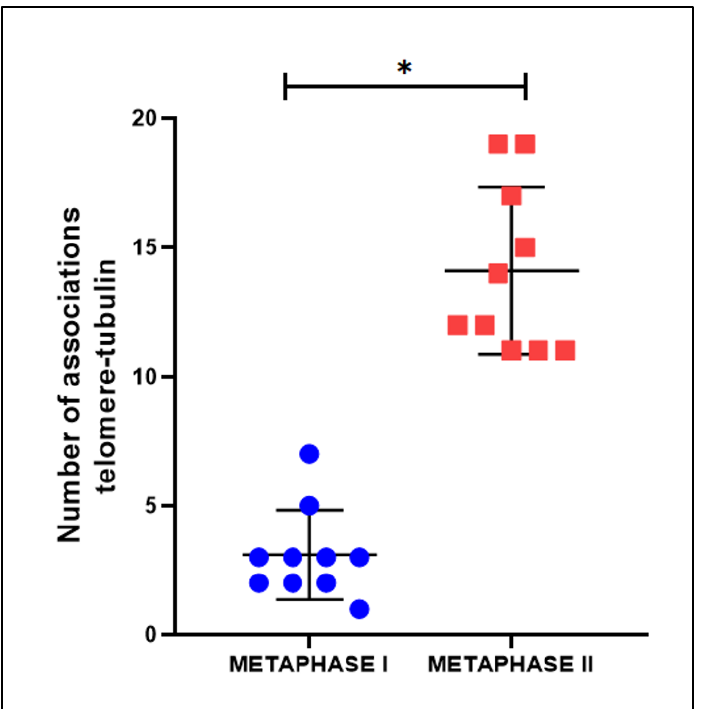
Figure 5. Quantification of associations of telomere – tubulin in metaphase I and metaphase II of T. maranhensis (n = 10 of each). (* p < 0.001).